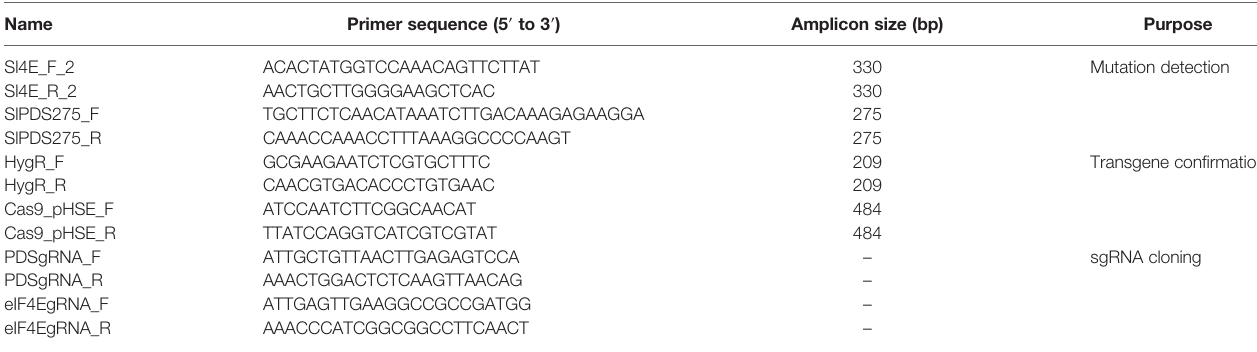
TABLE 1 | List of primers used in the present